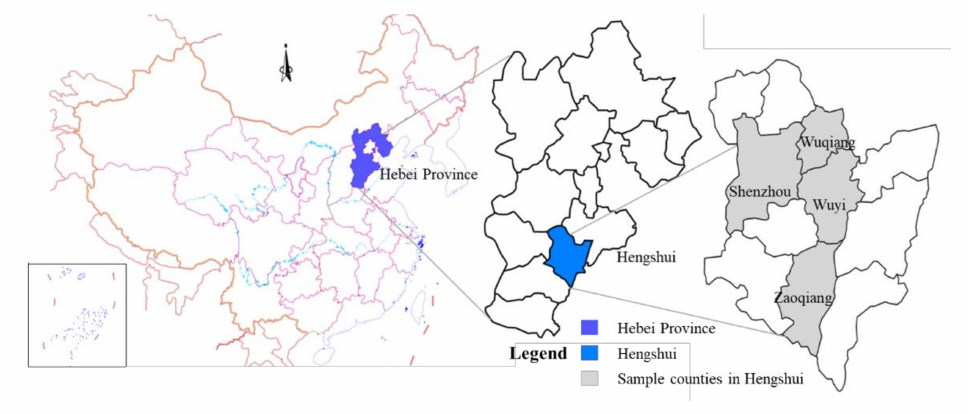
Figure 2. Location of sample counties in Hengshui prefecture of Hebei Province,